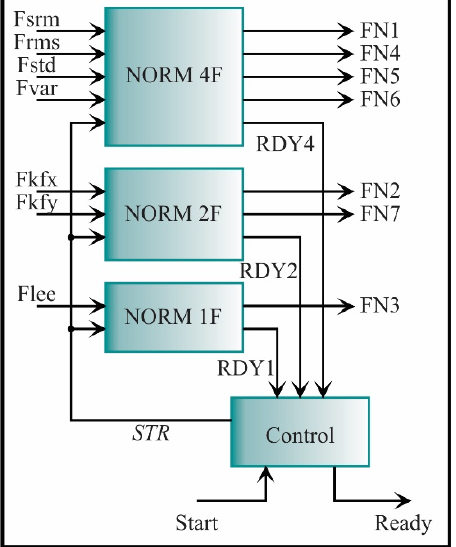
Figure 21. Architecture for computing the feature normalization.